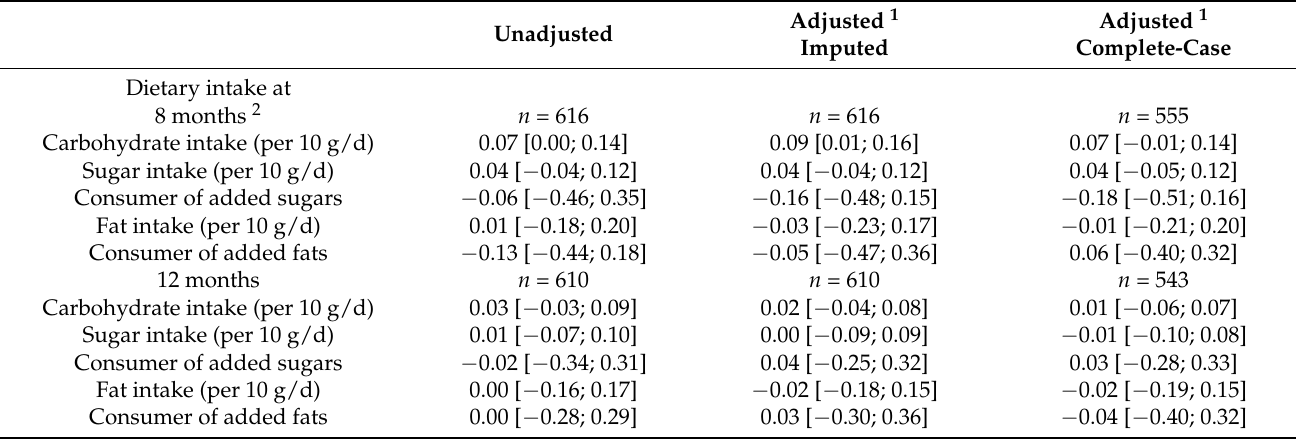
Table 5. Associations ( β (CI 95%)) between infant dietary intakes and their liking for fattiness-and-sweetness scores in young